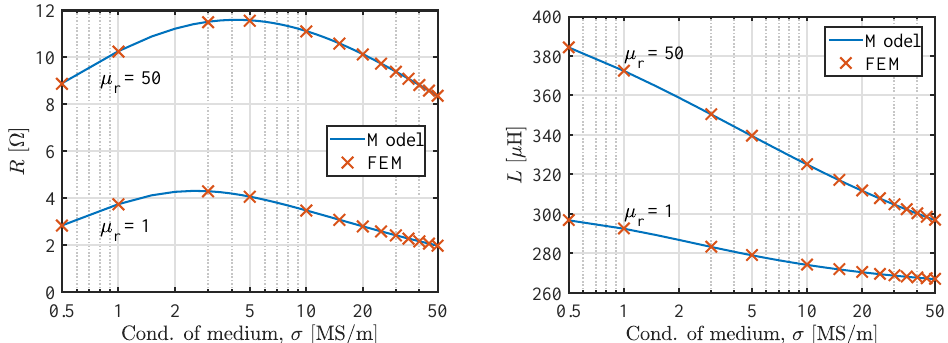
Figure 4. Comparison of the model predictions and results of the FEM study for resistance R ( left ) and inductance L ( right ) of the sensor at 60kHz depending on the conductivity of the medium σ for two cases of the permeability of the plate µ r = 1 and µ r = 50. The core has µ C = 100 and the shield µ S = 50.